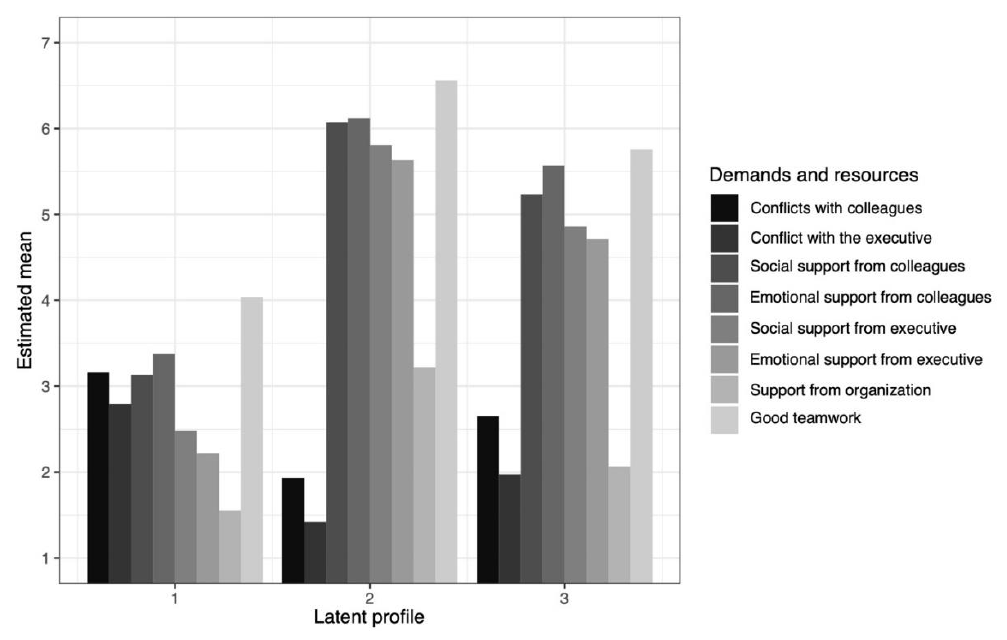
Figure 9. Latent profile solution for demands and resources (estimated means: conflicts with colleagues, conflicts with the executive, social and emotional support from colleagues, social and emotional support from the executive, support from organization, good teamwork; 7-point Likert scales; 1= never to 7= always/every day)